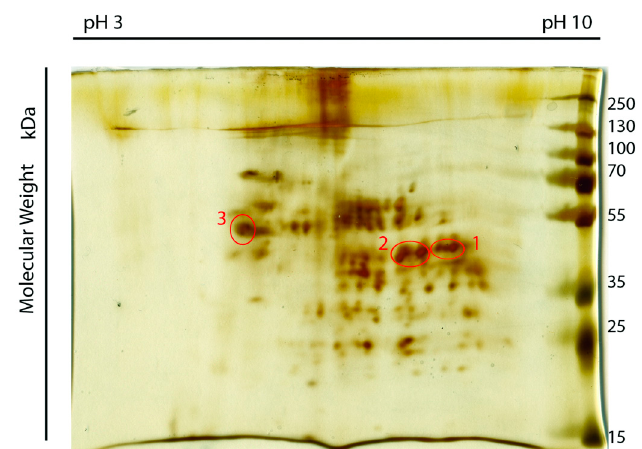
Figure 2. A representative 2-dimensional electrophoresis (2DE) gel. Co-IP eluate from WI/R cytoplasmic extract reacted with anti-HMGB1 was subjected to 2DE. Three unique protein regions (encircled in red) were identified through 2DE/MS identification and further verified using Western blot (WB).